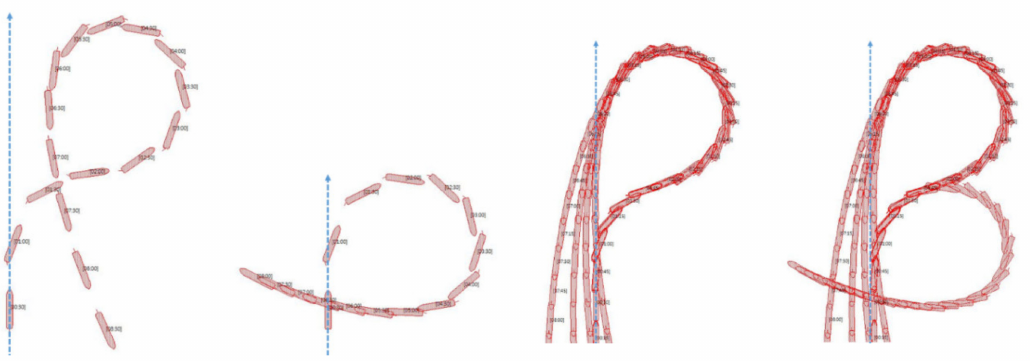
Figure 8. Williamson turn ( far left ), Anderson turn ( 2nd left ) and modified turns ( overlaid ).